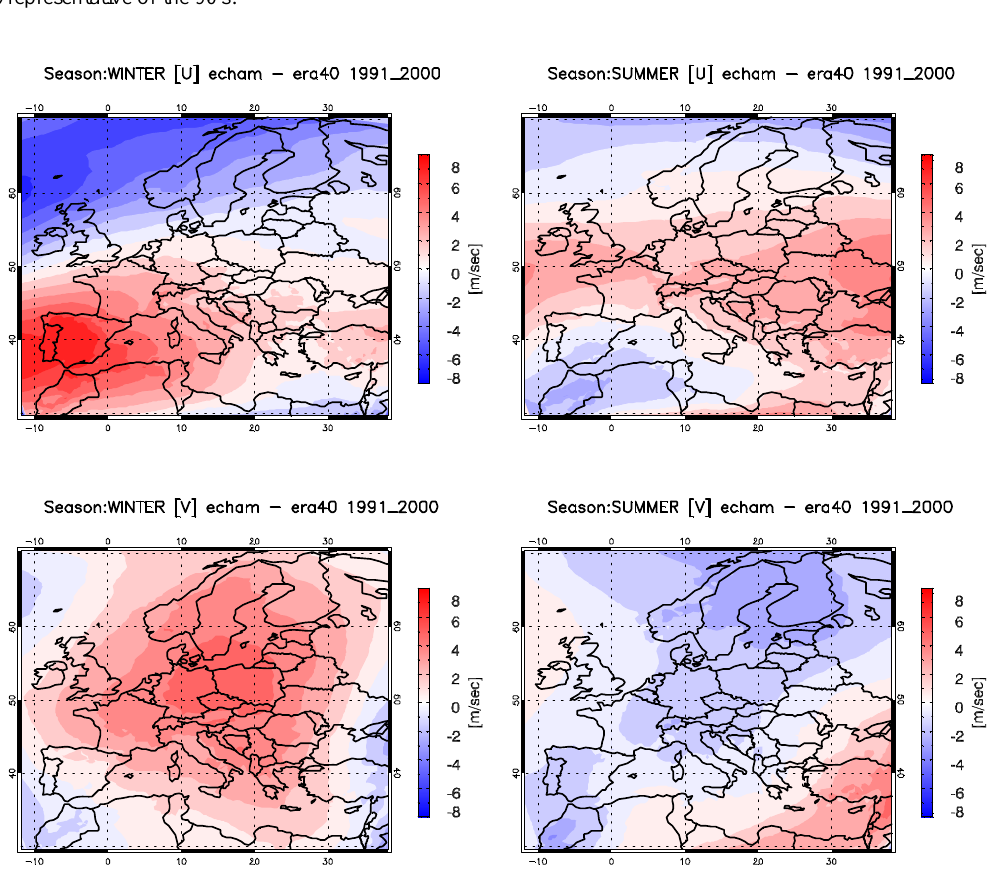
Figure 7. Differences in simulated average meridional (U upper panel) and zonal (V bottom panel) wind component fields between the ECHAM and ERA simulations for winter (left) and summer (right) representative of the 90s.